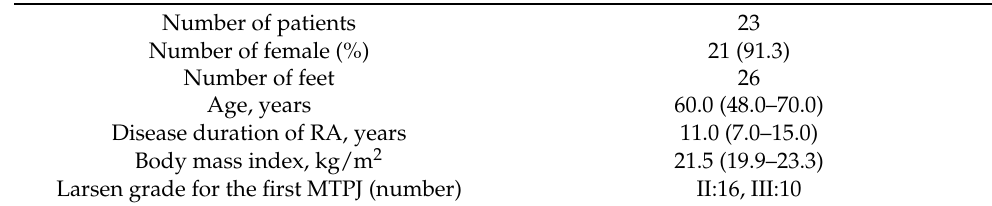
Table 1. Patient